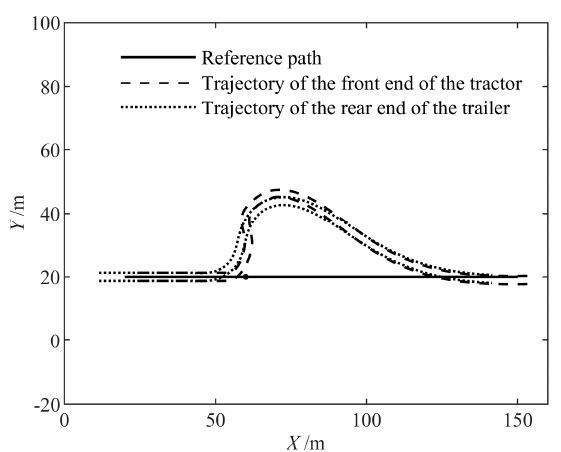
Figure 16. Partially enlarged view of Figure 15.